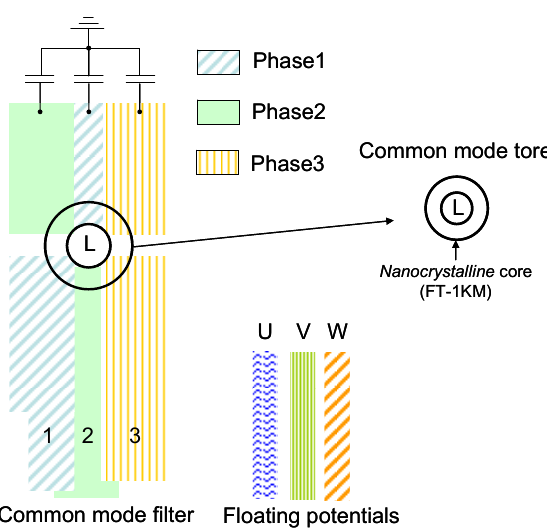
Figure 4. Description of the studied layout.